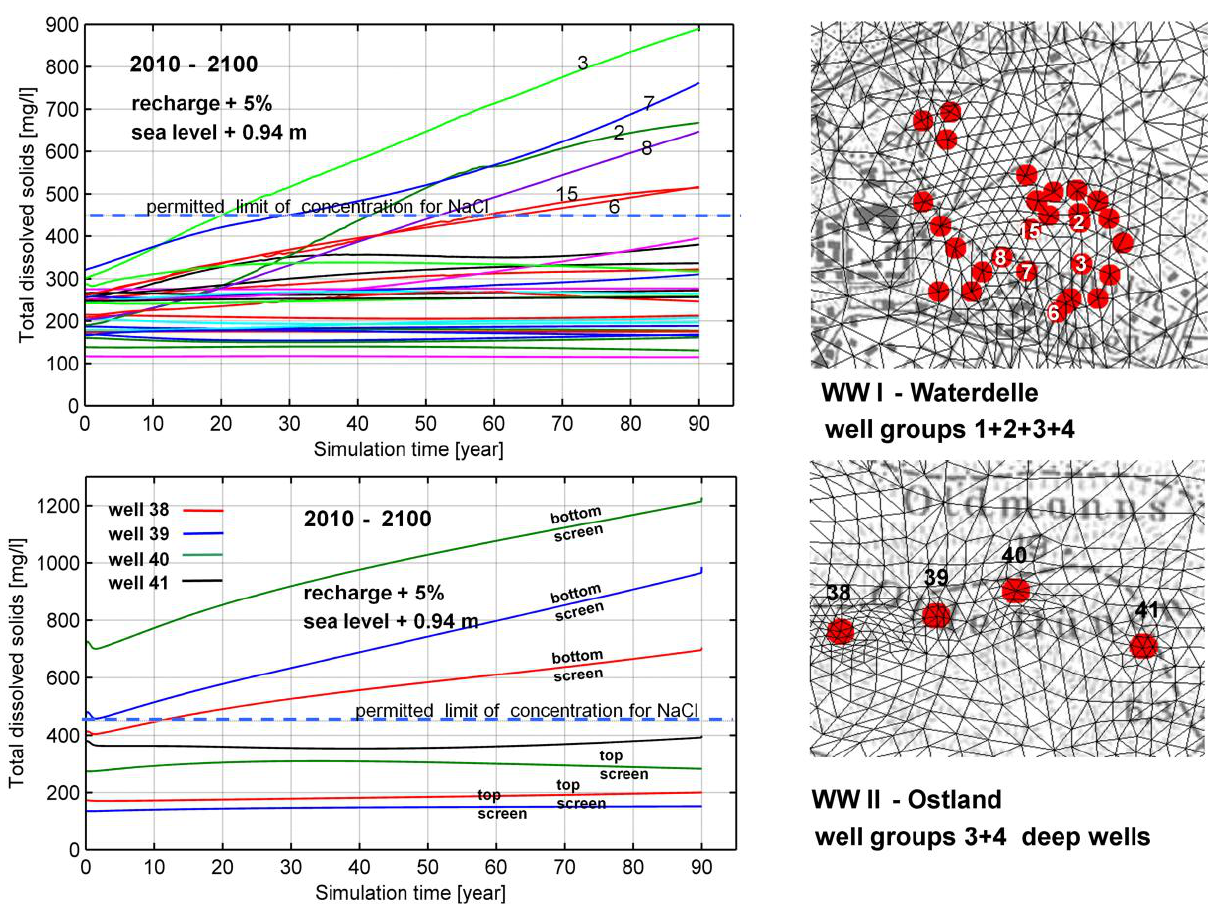
Fig. 20. TDS concentration [mgl − 1 ] computed in the screen of the water supply wells of WW I Waterdelle (top left panel) and WW II Figure 20. TDS concentration [mg/l] computed in the screen of the water supply wells of WW 2 Ostland (below left panel). In the right part of the figure location maps of the well fields are presented. I Waterdelle (top left panel) and WW II Ostland (below left panel). In the right part of the 3 figure location maps of the well fields are presented. 4 Hydrol. Earth Syst. Sci., 16, 3621–3643,